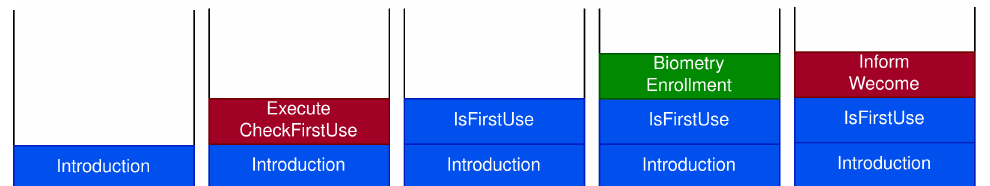
Figure 5. Movements of the stack when the DM traverses the specification tree in Figure 4 in Depth First order, and it considers the trigger values stored in the dashboard, as, for example, a true value as the output of the Execute CheckFirstUse terminal node.